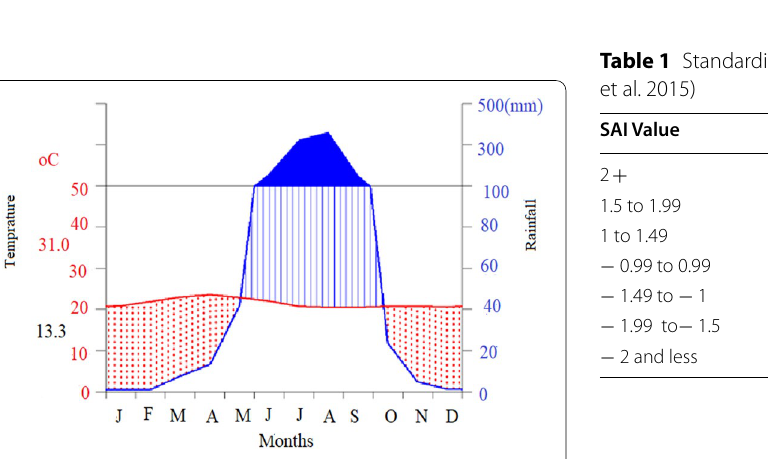
Fig. 5 Climate diagram of Zarima subbasin